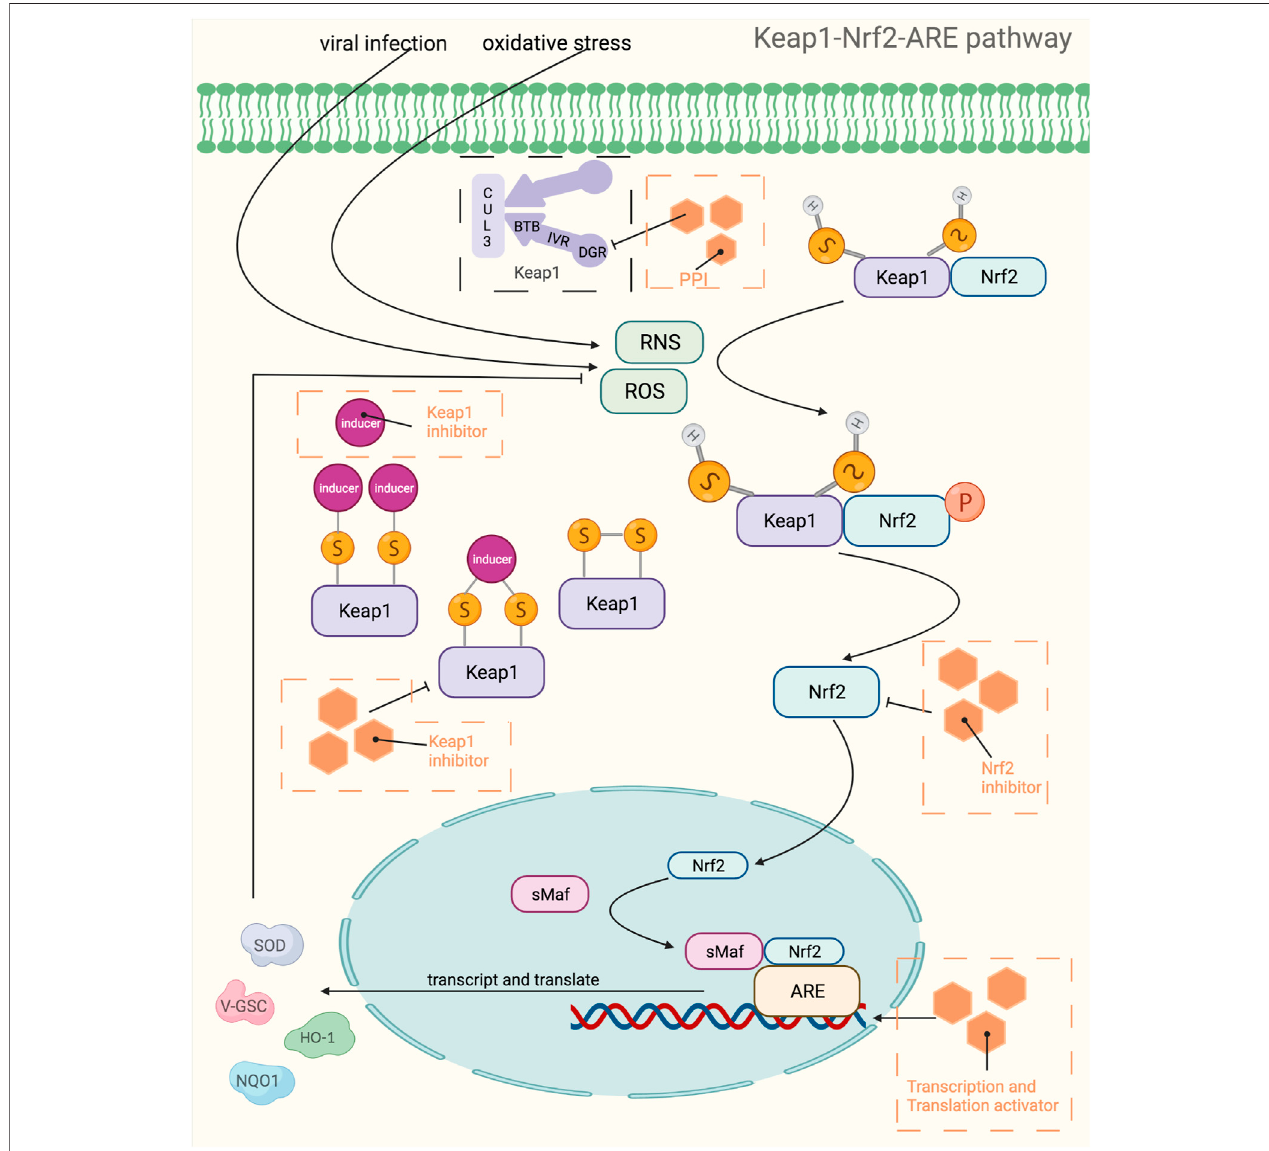
FIGURE 4 | Mechanistic map of the Keap1-Nrf2-ARE signaling pathway. BTB, broad complex, tramtrack and bric-à-Brac; CUL3, cullin 3; DGR, double glycine repeat; HO-1, Heme Oxygenase-1; IVR, intervening region; NQO1, NAD(P)H:quinone oxidoreductase 1; PPI, proton pump inhibitors; RNS, reactive nitrogen species; ROS, reactive oxygen species; sMaf, speci fi c macrophage activation factor; SOD, superoxide dismutase; GSC, glioblastoma stem cell. The fi gure is created with BioRender.com.